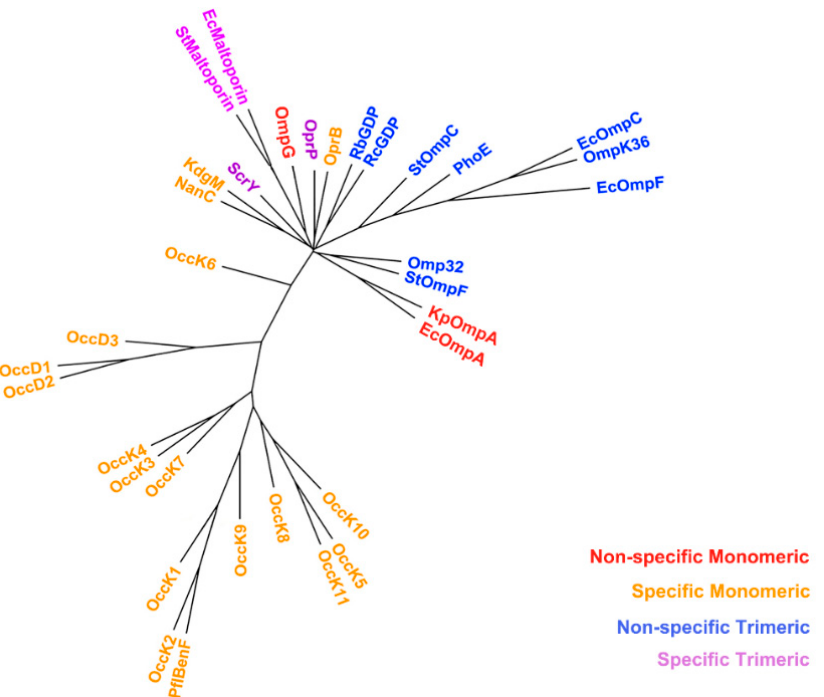
Figure 3. Phylogenetic tree of bacterial porins. Colors represent the four groups and the multimeric state of the porin based on the old classification system.